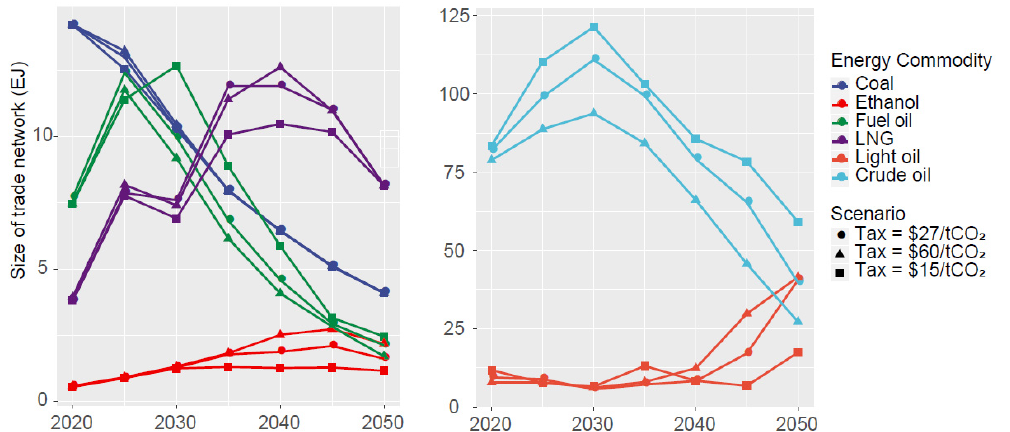
Figure 8. Sensitivity analysis with varying emissions tax levels. Colors represent energy commodities; shapes represent the various emissions tax scenarios. We present crude oil and light oil in a separate figure as these two commodities are traded at a much larger scale than the other commodities.